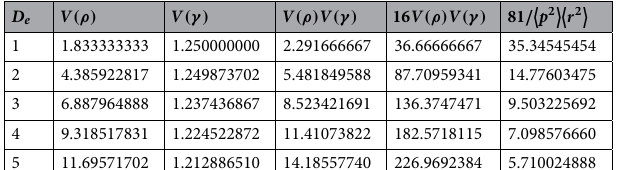
Table 5. Numerical results for variance uncertainty relations 16 V (ρ) V (γ) ≥ 81 / V (ρ) V (γ) ≥ 9 / 4 at the ground